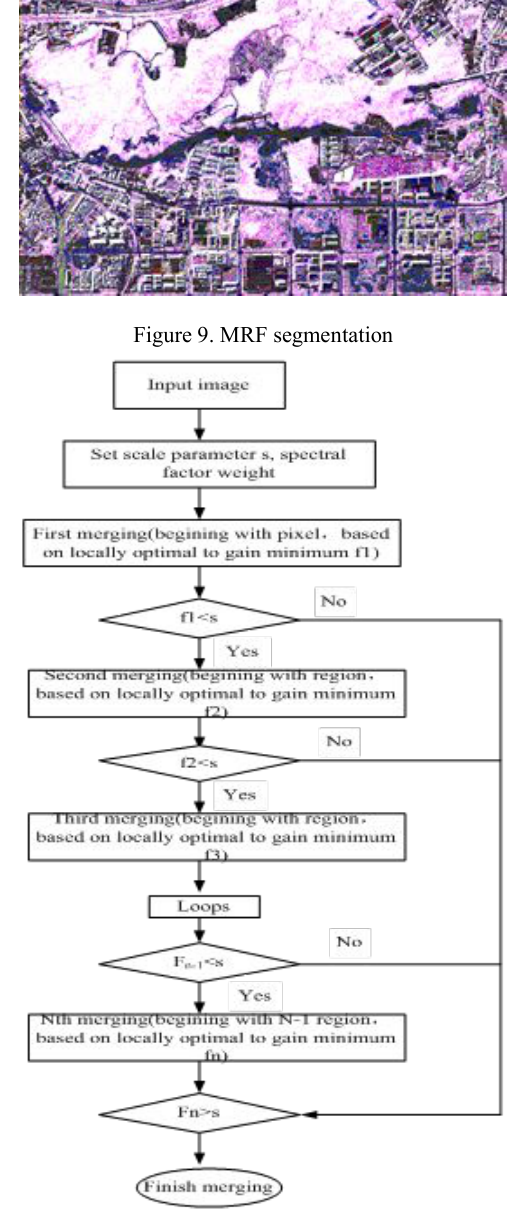
Figure 10. Multi-scale segmentation